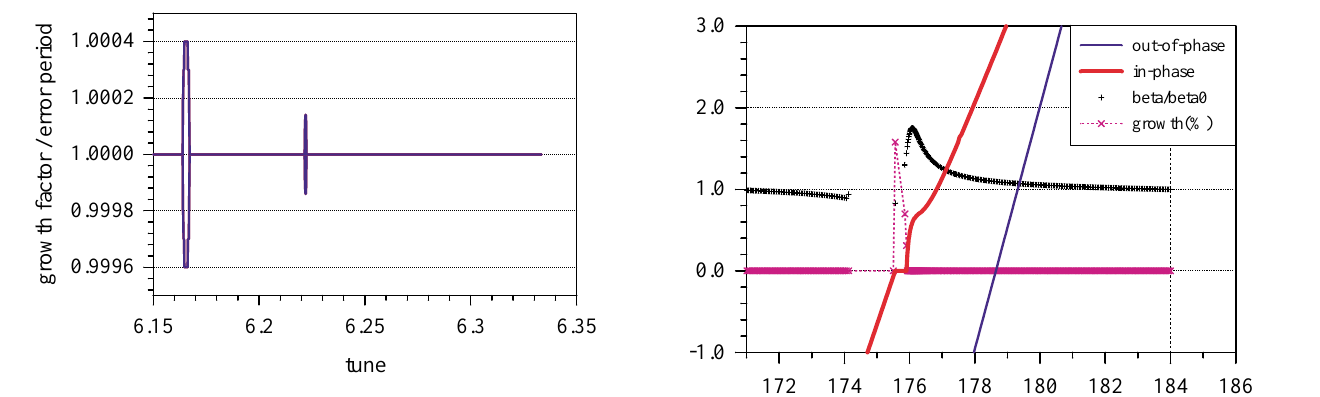
FIG. 14. (Color) Growth factors (per error period) for imper- fection driven envelope instability with working point n 0 x , y (cid:1) 6.333 and an error of 4% on harmonic n (cid:1) 25 . FIG. 15. (Color) Matched beta functions (in units relative to zero space charge value), phase advance of envelope perturbations (in units of degrees deviating from 360 ± ), and integer ( n